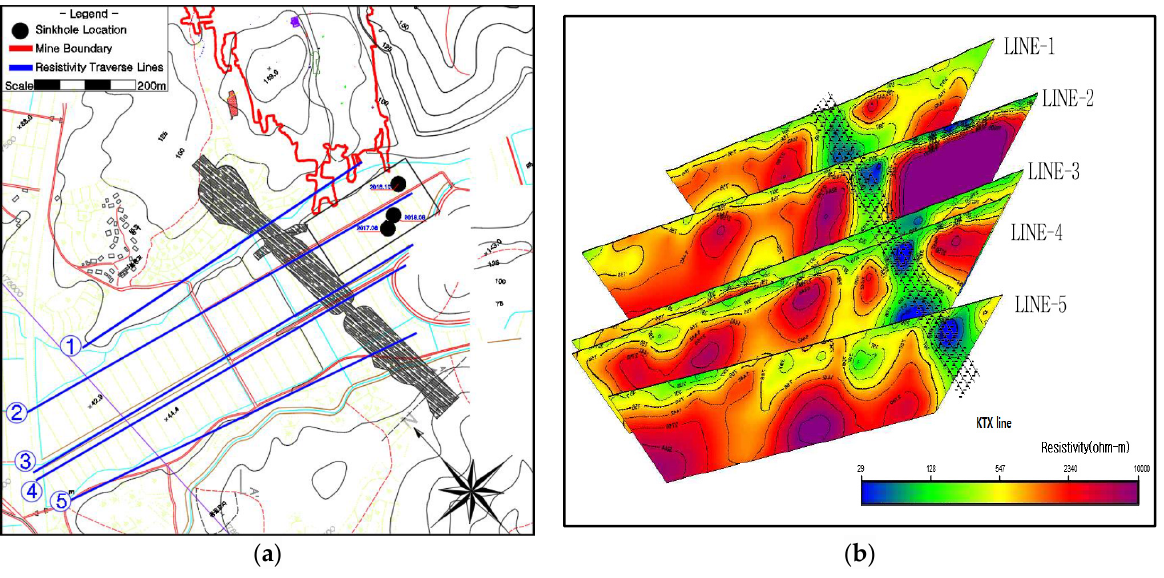
Figure 12. ( a ) Chosun University resistivity traverse lines in relation to the mine footprint and sink- holes ( b ) resistivity data of Chosun University, in railway embankment Area 2016. sinkholes ( b ) resistivity data of Chosun University, in railway embankment Area